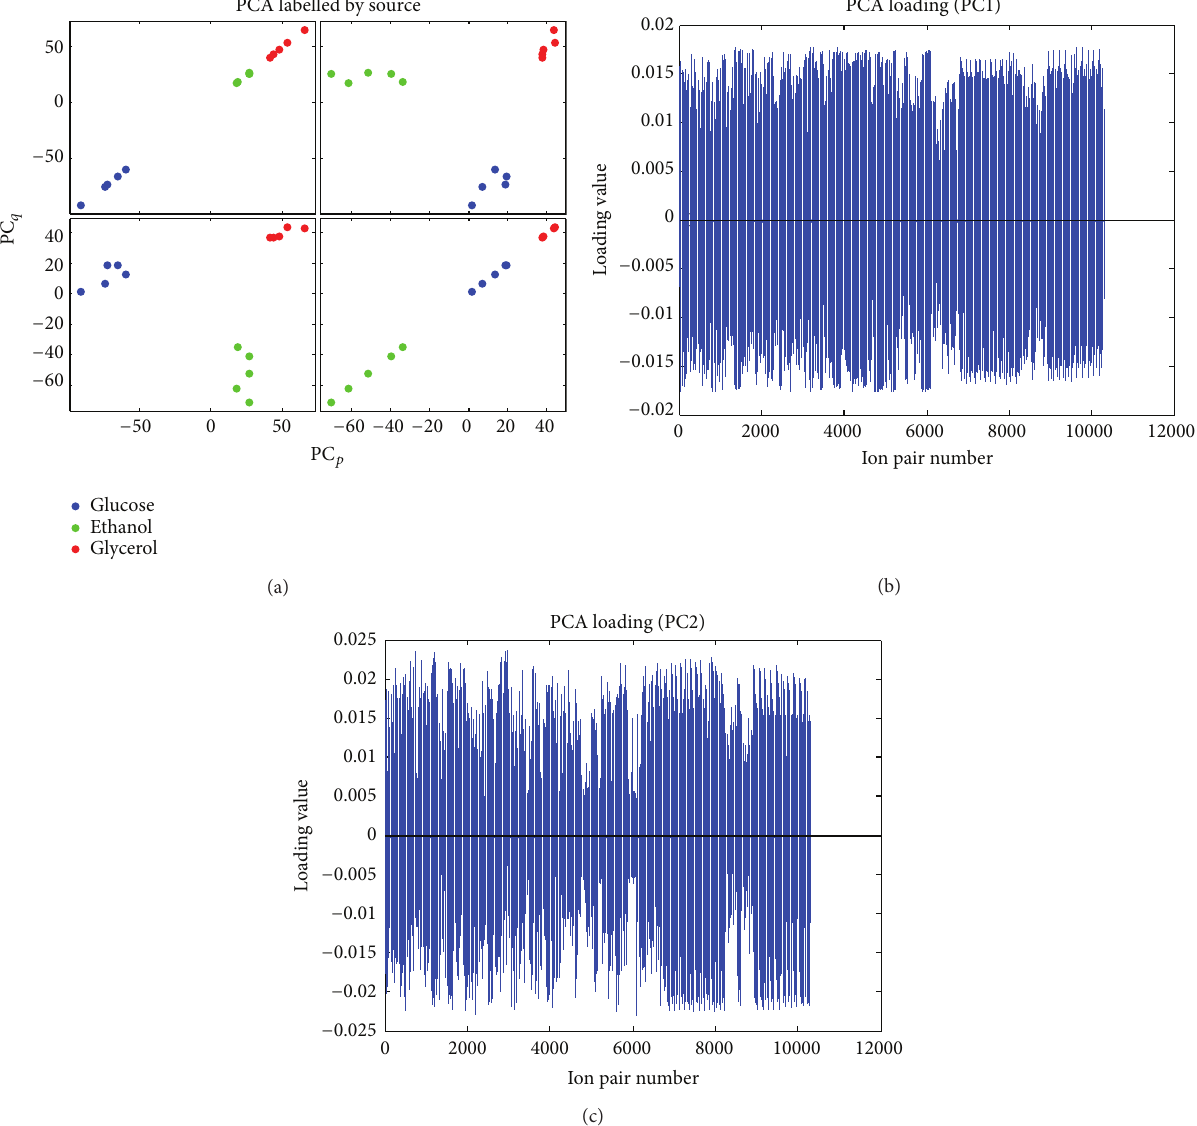
Figure 4: Standard PCA and loading show the clustering of different C-source cultures (including both ESI modes) and 5 replicates based on yield/slope of metabolite